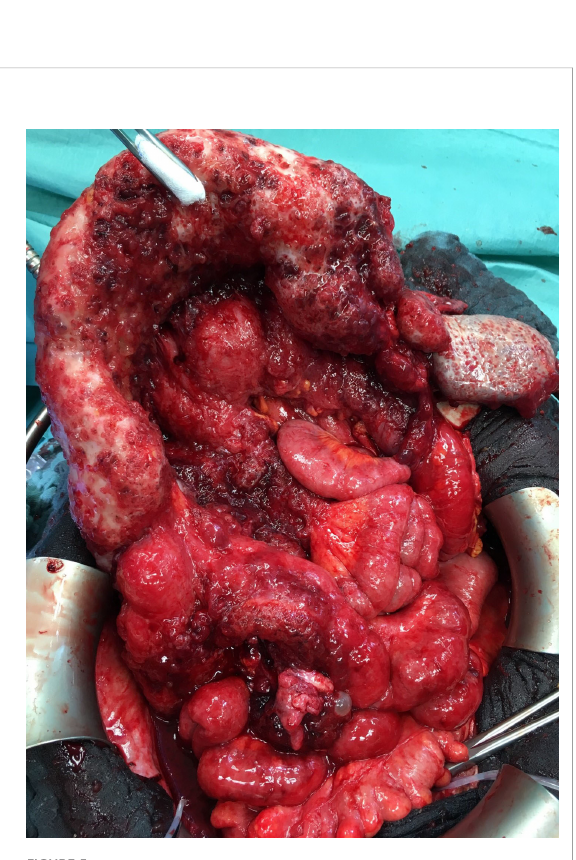
FIGURE 5 Intraoperative fi nding of peritoneal carcinomatosis of the mesenteric